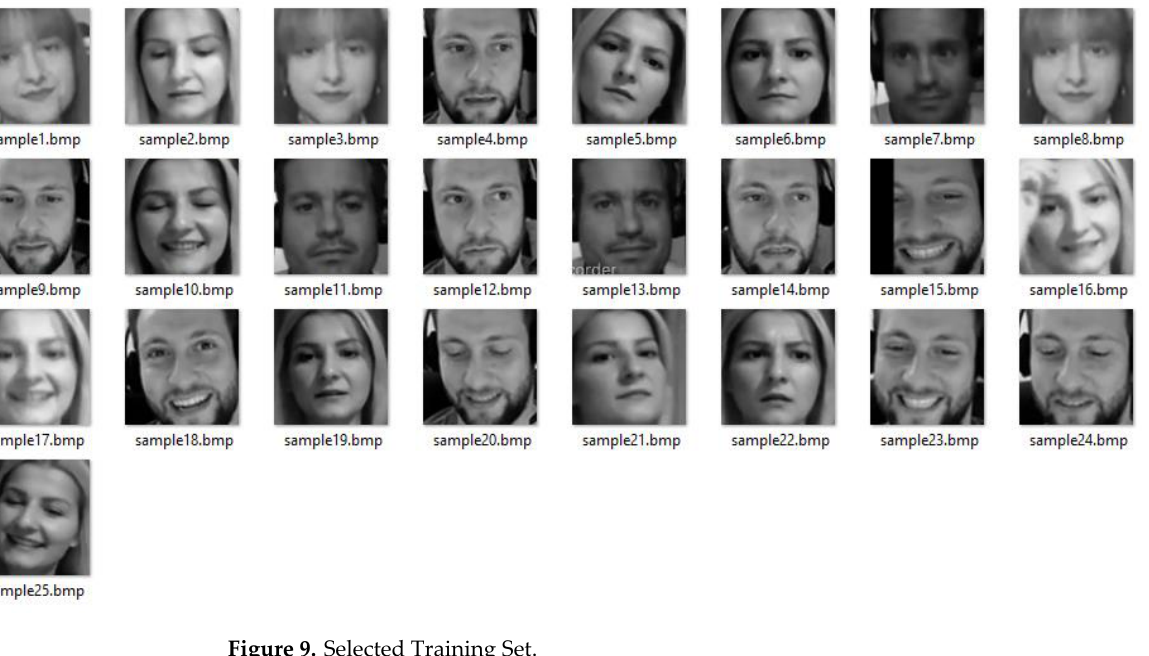
Figure 8. Four people into adjusted e-educational event.